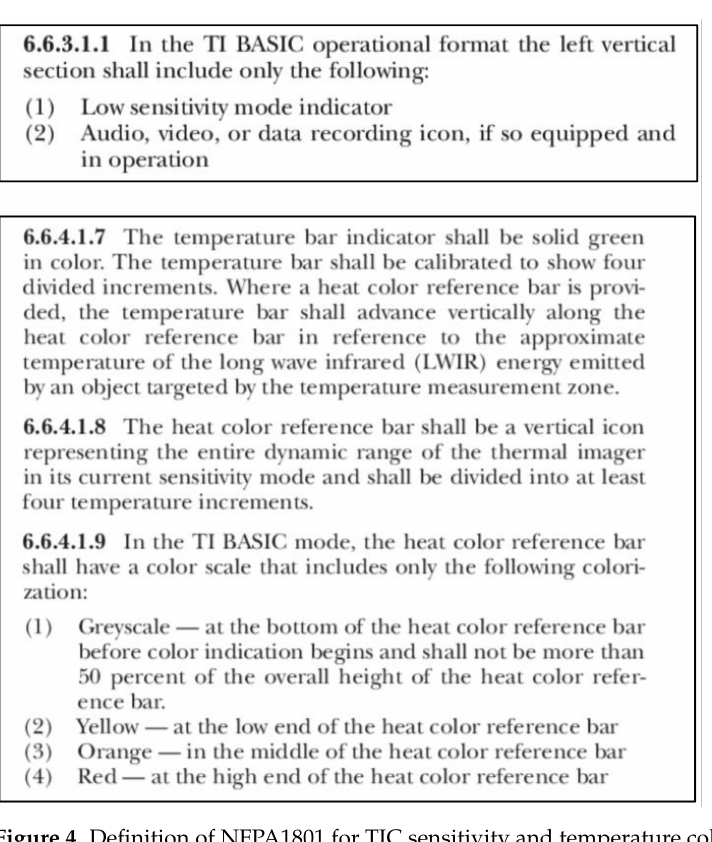
be 162.5 ◦ F (72.5 ◦ C), meaning that humans fall within the grayscale at the 105 gray level, as in Figure 4.